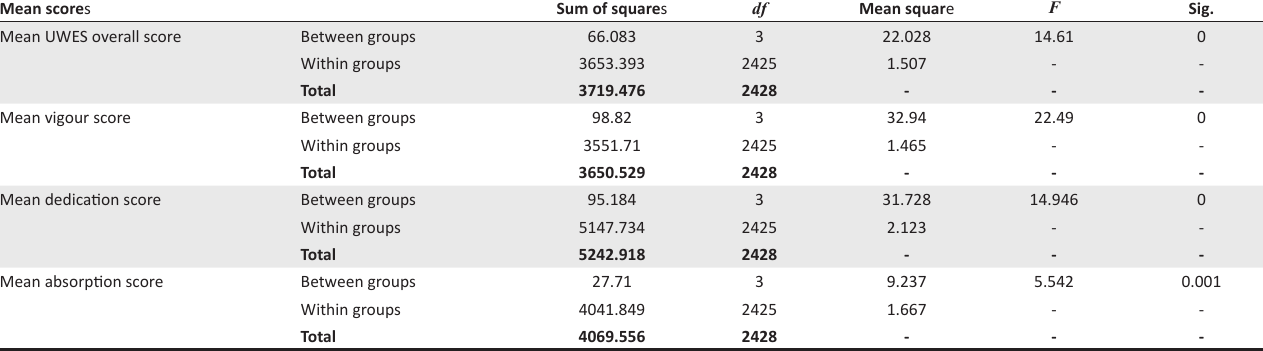
TABLE 4: Summary of ANOVAs between cultural groups for overall scales and sub-scales. Mean score